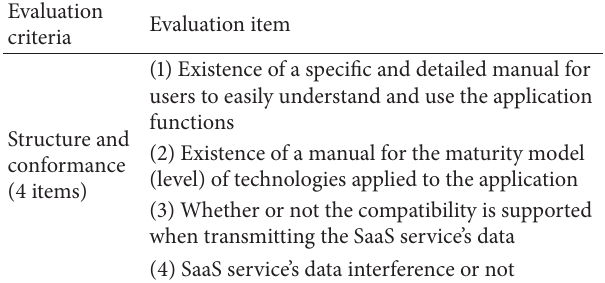
Table 7: Evaluation items of structure and conformance of IaaS. Evaluation criteria